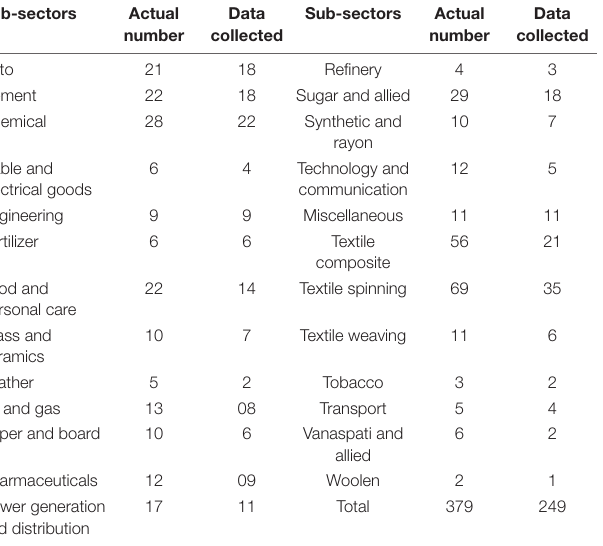
Data is collected from firms and excluding the missing and the unavailable data